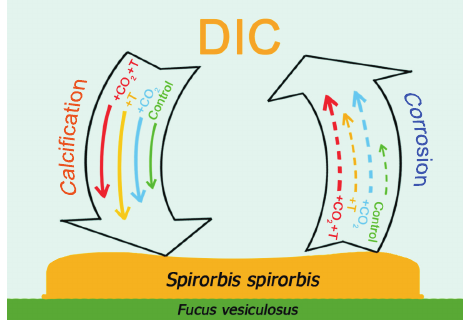
Figure 17. Synchronous calcification and shell corrosion in the undersaturated waters (mean (cid:127) < 0 . 8) of the autumn experiment. Length of arrows indicates relative magnitudes of treatment influ- ences on shell calcification (left, solid arrows) and shell corrosion (right, dashed arrows) respectively. Shell growth showed little vari- ability between treatments, except for increased growth in the + T treatment. Corrosion was strongly increased in the high-CO 2 treat- ments and slightly enhanced in the + T treatment. DIC: dissolved inorganic